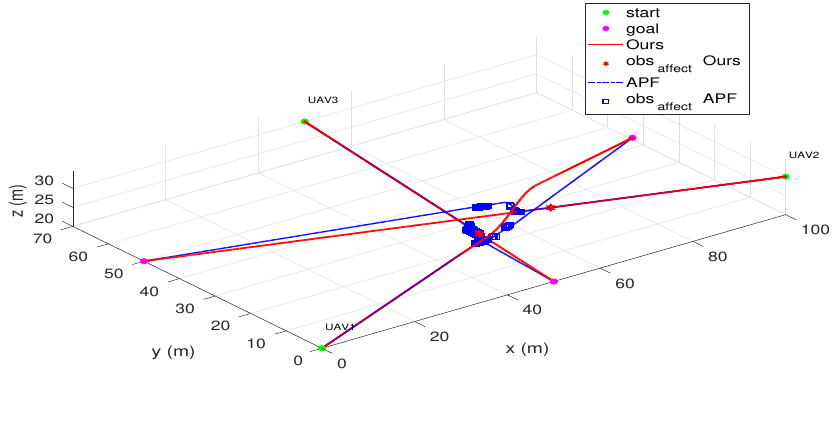
Figure 14. 3D view of the dynamic obstacles only case.